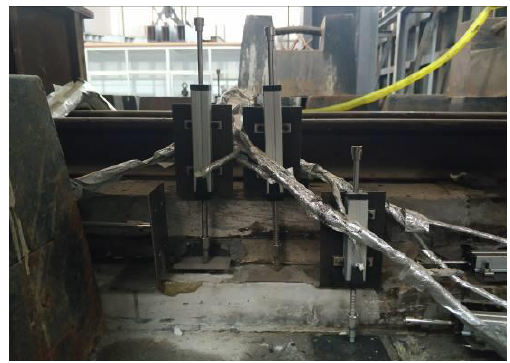
Figure 6. Interlayer relative displacement gauges installation diagram.